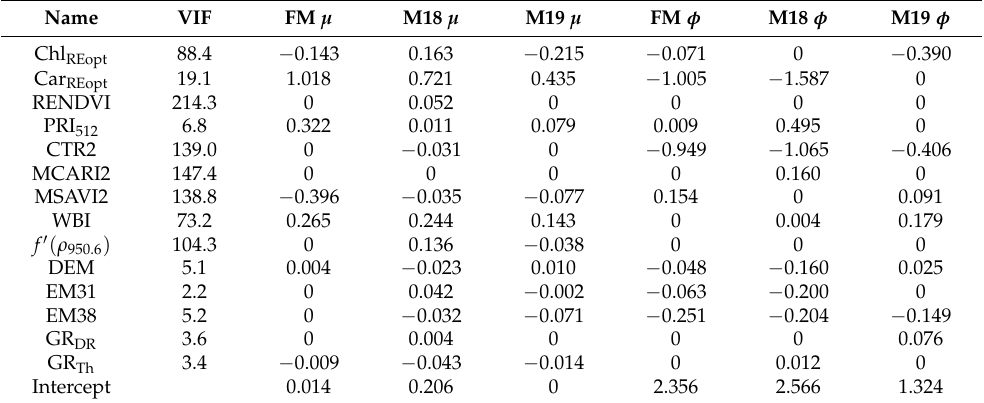
Table 4. Variance inflation factors (VIF) from multicollinearity analysis of the evaluation variables. The estimated coefficient values from fitting the interannual full model (FM) and subset models (M18, M19) with boosted beta regression (early stopping after 300 iterations, learning rate: 0.05, coefficient values rounded to three